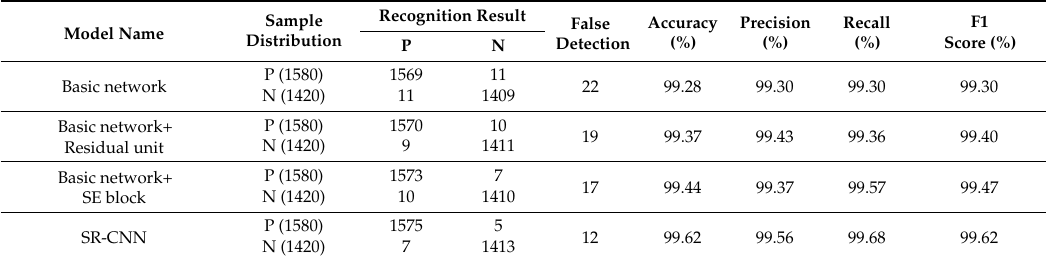
Table 6. The performance of different models on the test